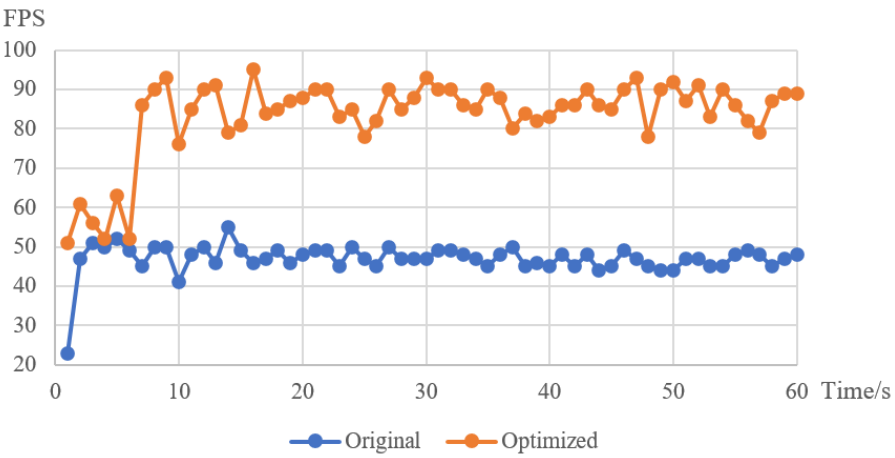
Figure 9. Comparison of scene ‐ rendering efficiency between original and optimized scenes.